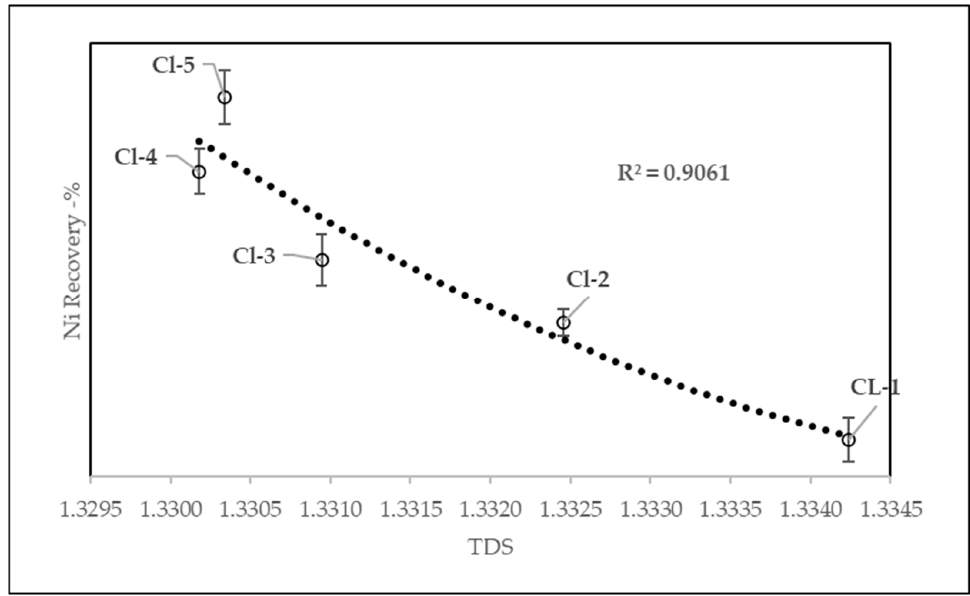
Figure 4. Effect of TDS in recycled process water on the plant recovery of nickel.